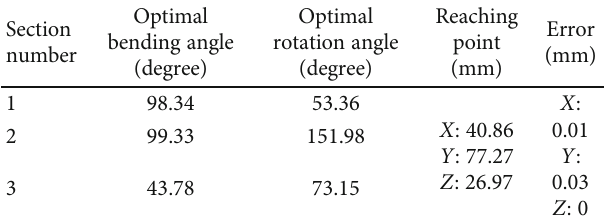
Table 5: Optimized results for reaching target point.